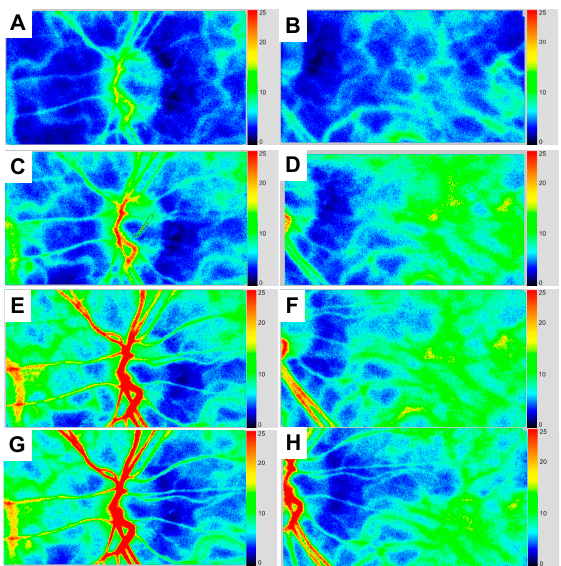
Figure 3. The time course exhibited by the laser speckle flowgraphy color composite map. LSFG images in the optic nerve head and the choroid of the left eye at 4 days ( A , B ), 2 weeks ( C , D ), 3 months ( E , F ), and 5 months ( G , H ) after the baseline visit. The LSFG images showed that warm colors increased over time. The Mean blur rate and blowout scores in each vascular bed also increased after treatment.